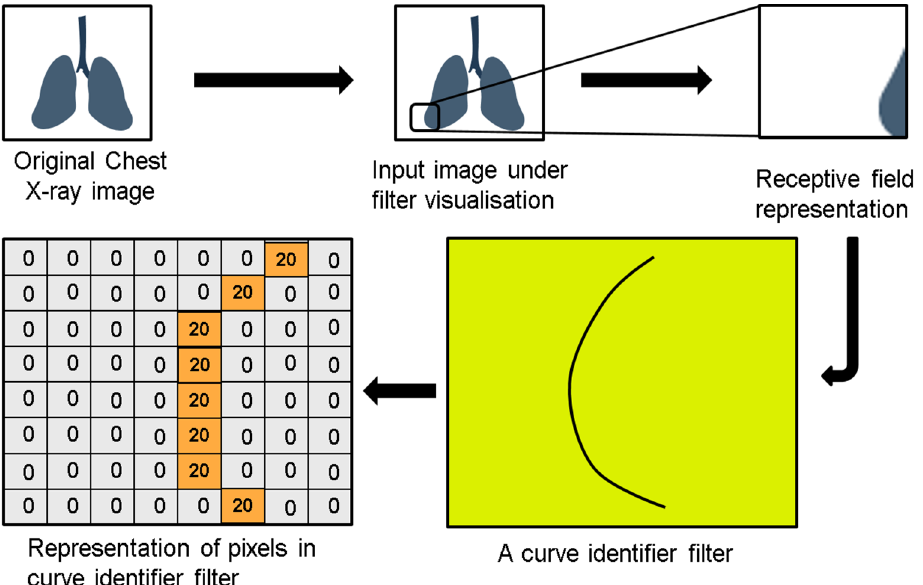
Figure 6. Curve identifier filter and its activation for a chest X-ray image.